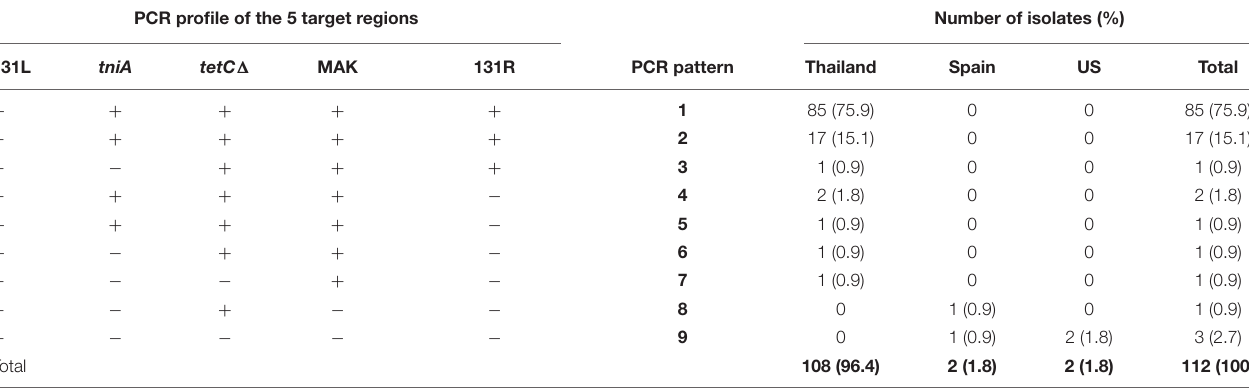
TABLE 1 | PCR patterns showing the presence of five target regions identified in 112 isolates of S . 4,5,12:i:- related to geographical sources (Thailand, Spain, and the U.S.). PCR profile of the 5 target